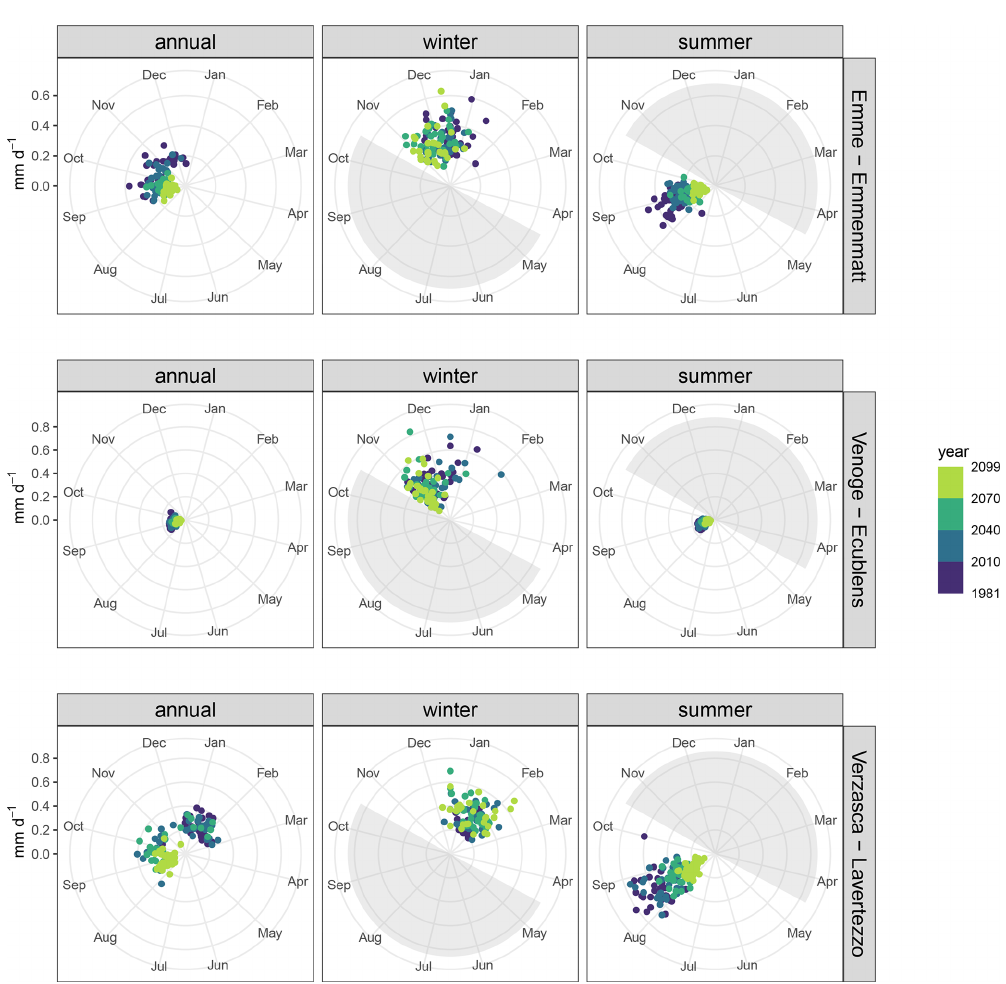
Figure 5. Multimodel median of magnitude and seasonality of low flows and seasonal low flows in lower-lying catchments: Emme (top row panels), Venoge (middle row panels), and Verzasca (bottom row